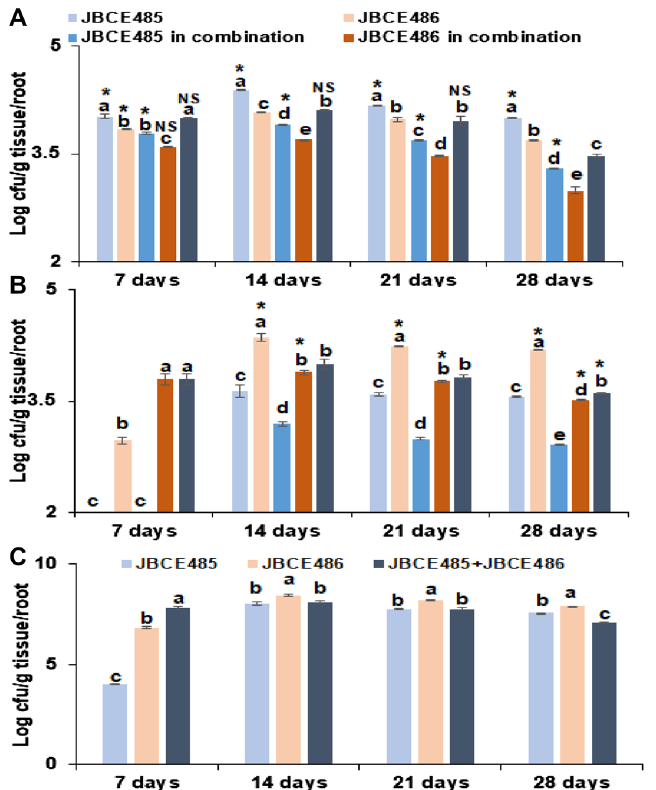
Figure 9. Population dynamics of Pseudoxanthomonas sp. JBCE485 and Variovorax paradoxus JBCE486 cells on chive roots. Seeds were treated with individual and combined cell suspensions (1 × 10 7 CFU/mL) of JBCE485 and JBCE486 and sown in horticultural soil. ( A ) Each bacterial population on the root surface at 7, 14, 21, and 28 days after treatment. All tissues below soil surface at 7 days after growth and roots at 14, 21, and 28 days after growth were collected and cells per g tissues were estimated by serial dilution plating on LB medium containing rifampicin (25 µg/mL) and tetracycline (25 µg/mL) for JBCE485 and JBCE486, respectively. ( B ) Each bacterial population inside of roots. Surface sterilized roots were macerated in buffer and plated on LB media. ( C ) Total population of bacteria residing on the surface and inside of roots. The experiment was replicated two times with 15 seedlings per replicate. The data are represented as the standard deviation of 5 independent biological samples. Bars with the same letter(s) do not differ significantly at P = 0.05 at each timepoint for respective compartments. *Indicates significant difference at P = 0.05 of a treatment with respect to niche; NS not